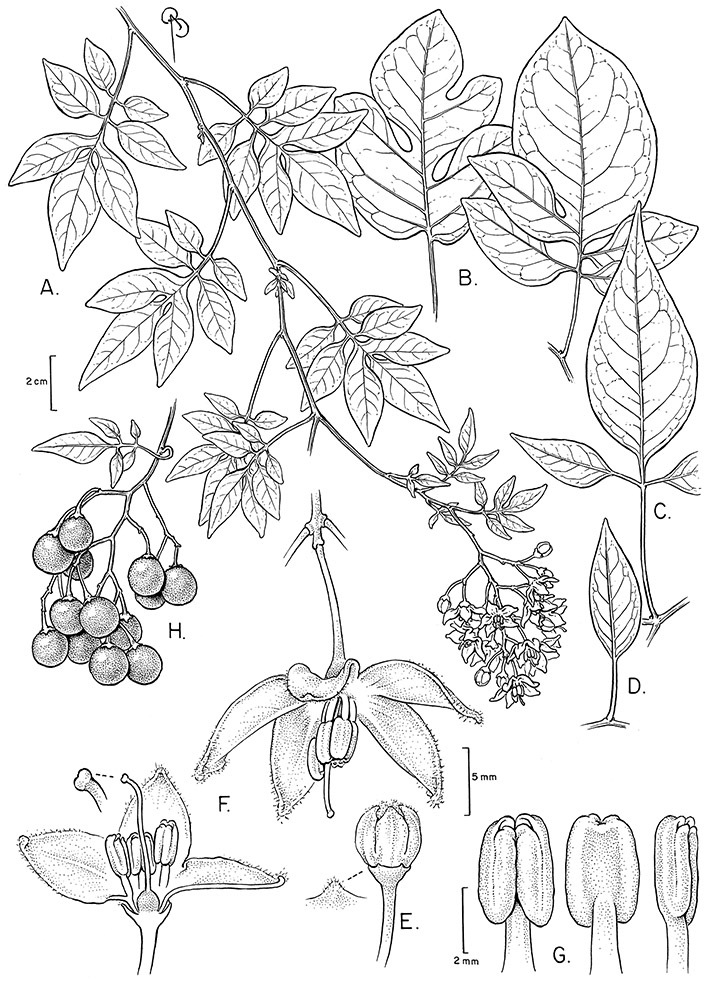
Solanum seaforthianum Andrews. (A drawn from Baker 10374
B H drawn from Thompson 947
C drawn from Hatschbach 60388
D drawn from Renderos 517; E-g drawn from McVaugh 20220). Illustration by Bobbi Angell.